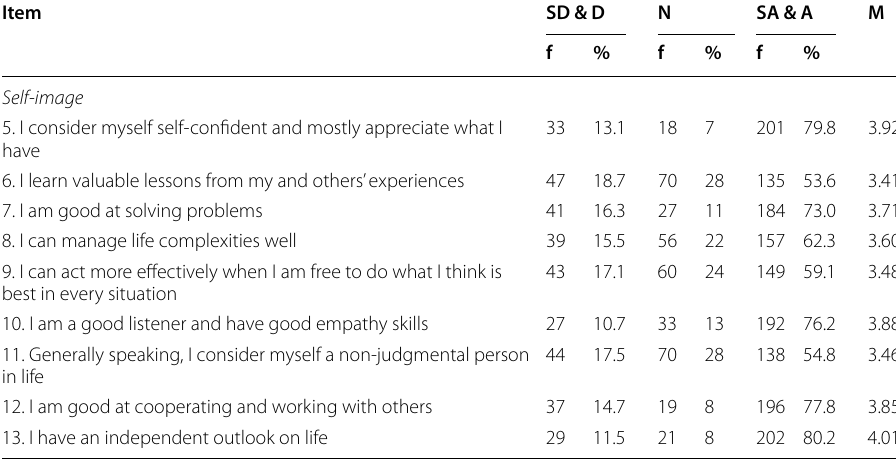
Table 8 Frequency, percentage, & mean scores rf responses to APPRSQ (self-image)